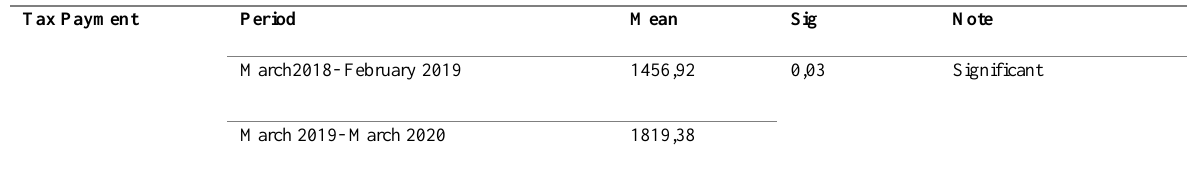
Table 2: Result of Hypothesis Two Test